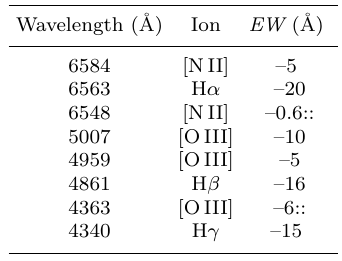
Table 1. Emission lines in the 2011 spectrum of V2282